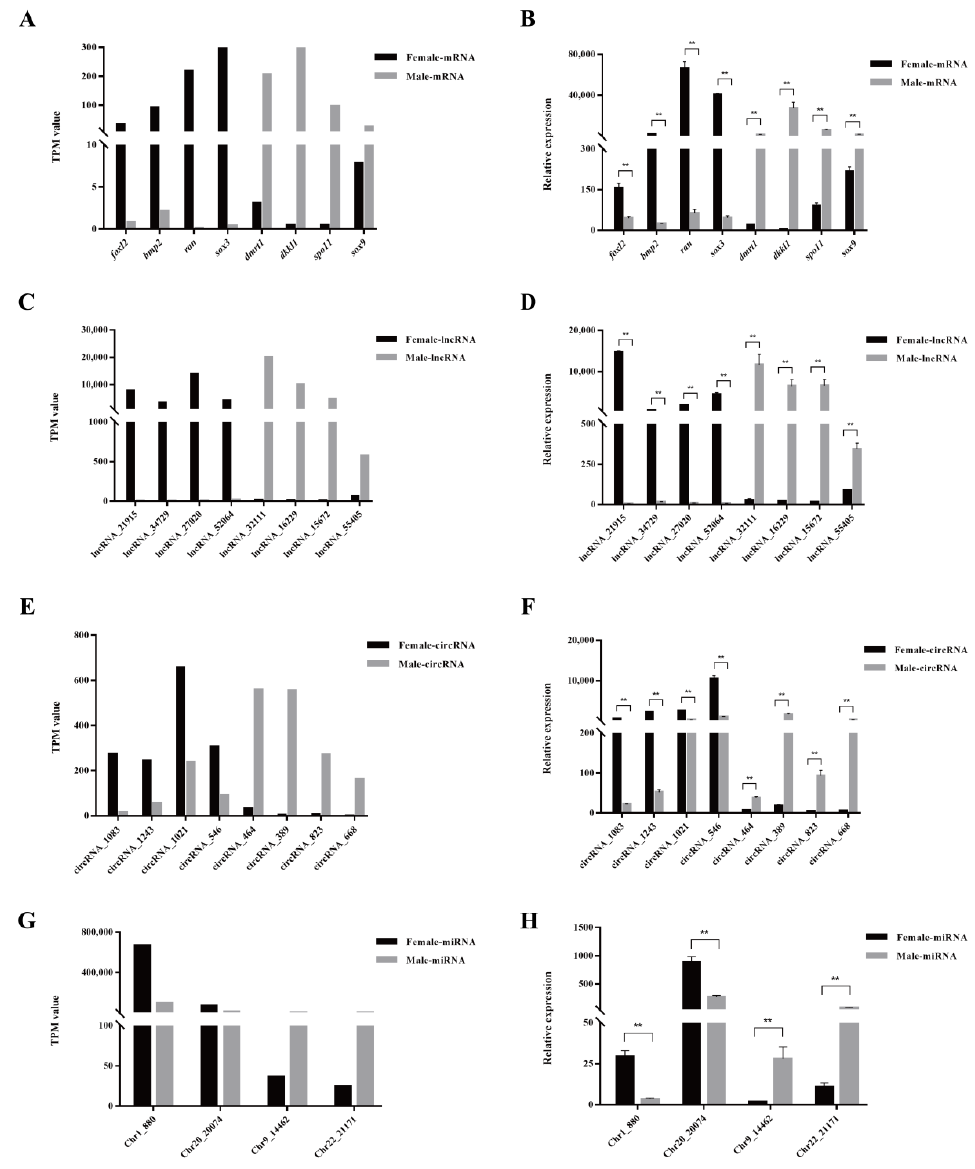
Figure 3. Validation of RNA-seq data by qRT-PCR. ( A , C , E , F ) show the tendencies of mRNAs, lncRNAs, circRNAs, and miRNAs, respectively, in RNA-seq data using the TPM value. ( B , D , F , H ) rep- resent the relative expressions of candidate mRNAs, lncRNAs, circRNAs, and miRNAs, respectively, by qRT-PCR. The TPM value is represented as the means, while the data of the relative expressions shown are the means ± SEM. The asterisk indicates significant differences. ** p <